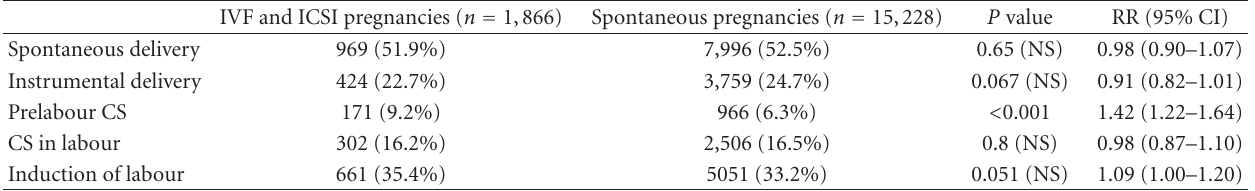
Table 2: Labour characteristics.